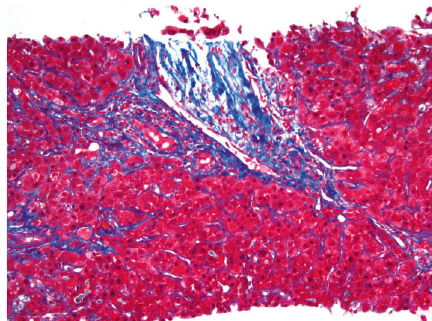
Figure 3: Trichrome stain (40 × ) showing portal and periportal fibrosis, as well as focal sinusoidal collagen